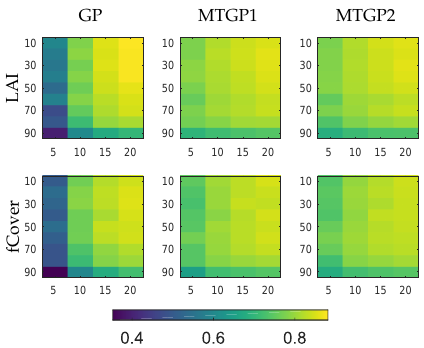
Figure 6. Mean predictive R 2 of multitask GP as function of training set size (x-axis) and illumination variations (y-axis) evaluated on simulated dataset. The x-axis of the plots is training set size and the y-axis of the plots is θ var